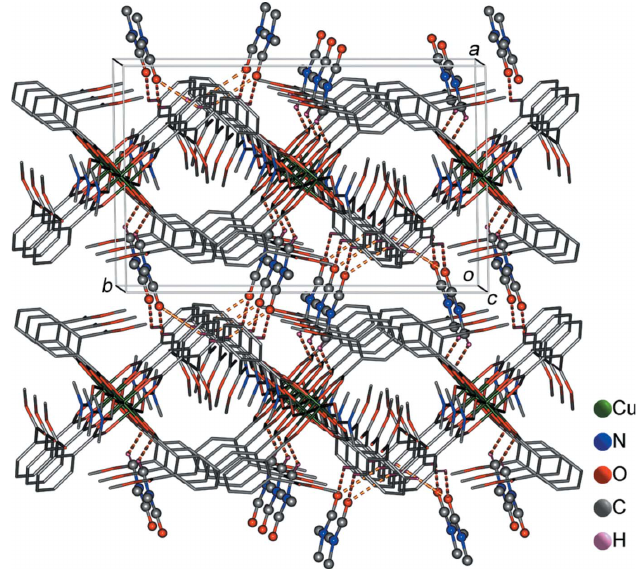
Figure 3 The crystal packing of (I) showing the three-dimensional supramolecular